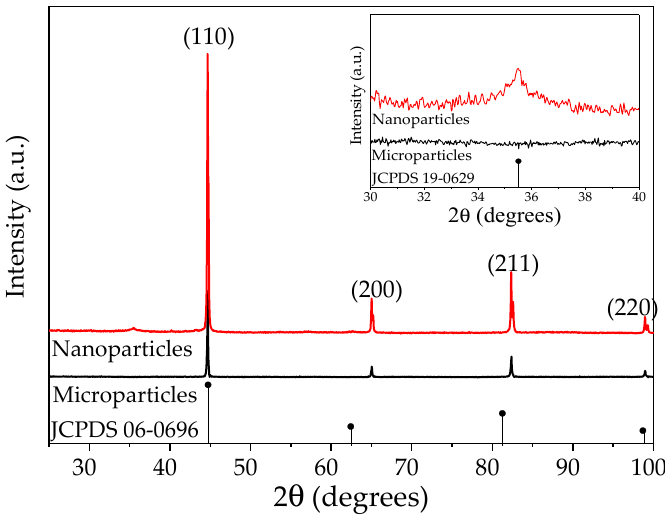
Figure 9. XRD patterns of nano- and microparticle powders.